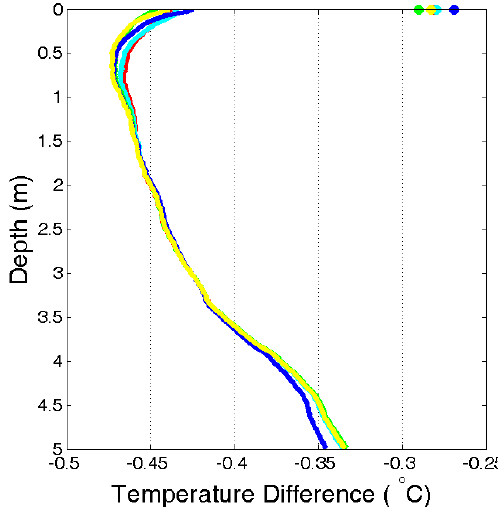
Fig. 10. Mean temperature difference profile for all available data Fig. 10 : Mean temperature difference profile for all available data (1,165 profiles collectively Fig. 8. IO07 data set: differences between the modelled and in situ (1165 profiles collectively from the GC99, GL03 and IO07 data from the GC99, GL03 and IO07 datasets). The blue, yellow, green, red and cyan profiles repre- Fig. 8 : IO07 dataset: differences between the modelled and in-situ measurements for the Base measurements for the Base (blue), Blend (yellow), EWB (green), sets). The blue, yellow, green, red and cyan profiles represent the sent the mean temperature difference profiles of the Base, Blend, EWB, EST and BST models, (blue), Blend (yellow), EWB (green), EST (red) and BST (cyan) models. The surface points EST (red) and BST (cyan) models. The surface points are the dif- mean temperature difference profiles of the Base, Blend, EWB, respectively. The transparent colour-coded regions represent the 95% confidence intervals. are the differences between modelled and M-AERI skin temperatures. ferences between modelled and M-AERI skin temperatures. EST and BST models, respectively. The transparent colour-coded regions represent the 95% confidence